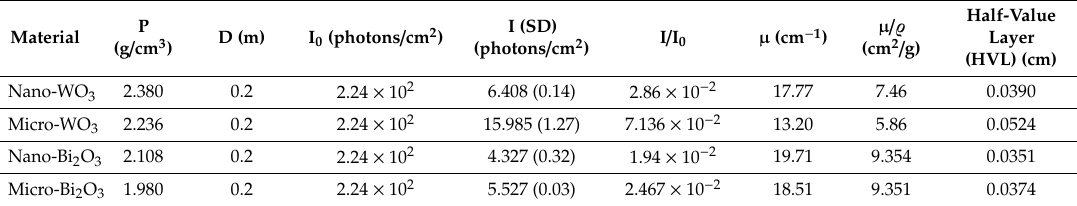
Table 2. Characteristics and X-ray shielding properties of the materials.